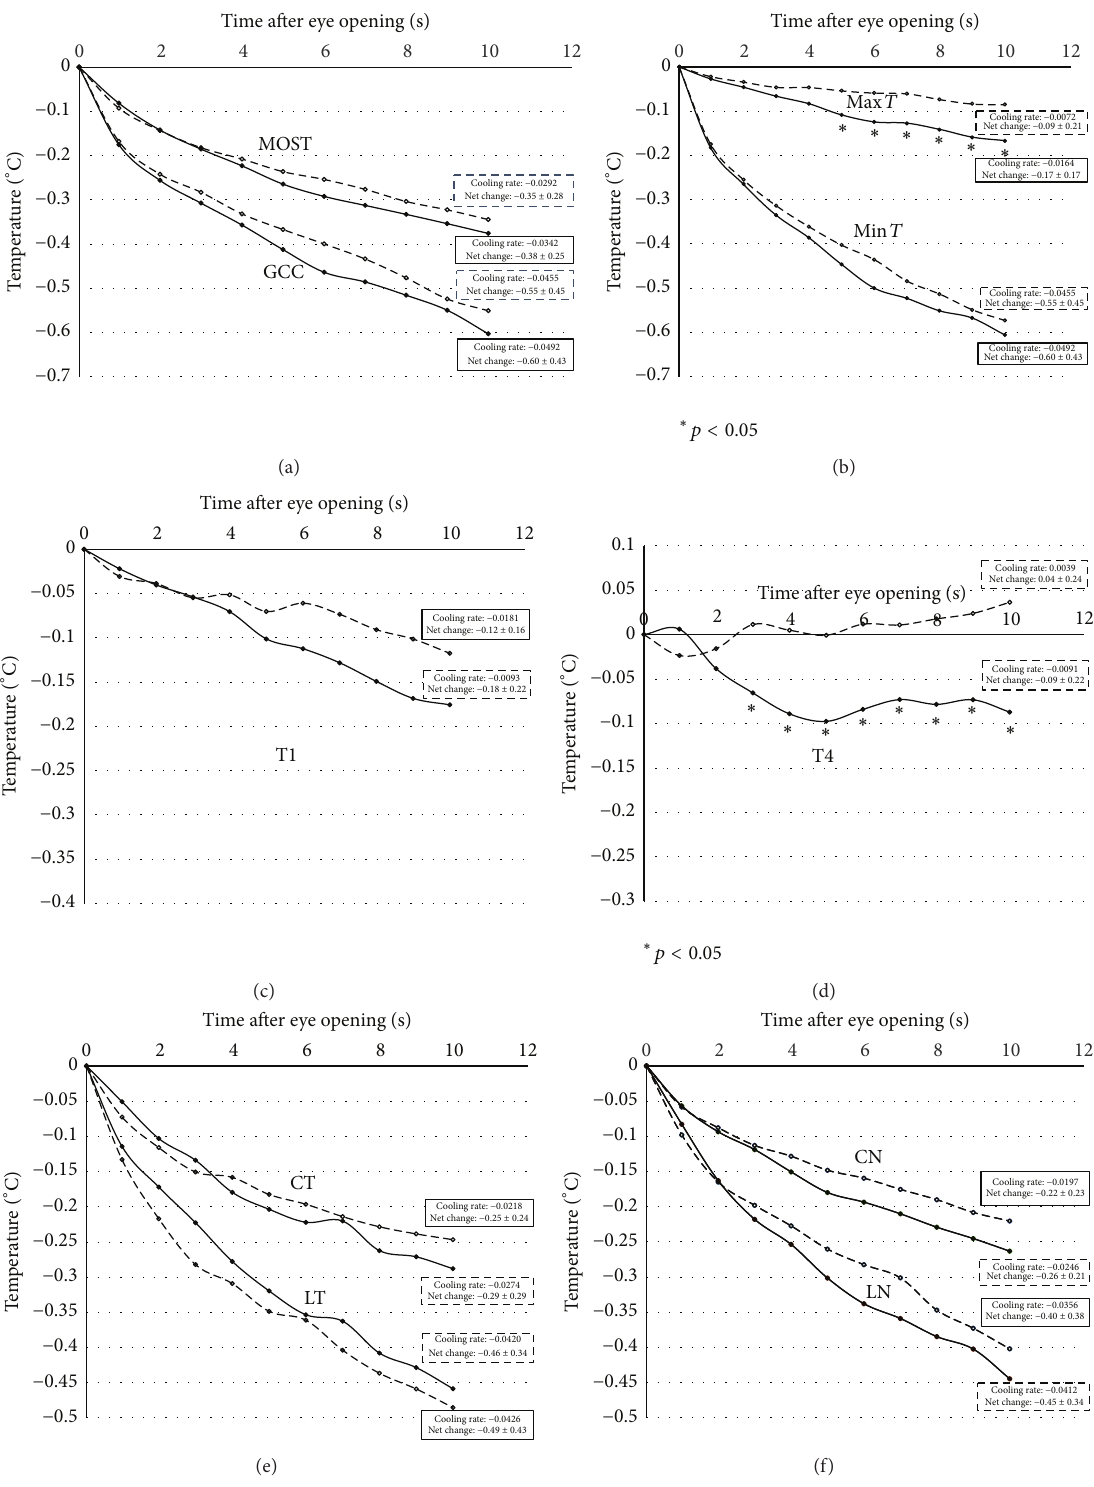
Figure 3: (Dynamic measures) graphs showing the mean change OST (relative to baseline) during the 10 s sustained eye opening: (a) GCC and MOST; (b) Min 𝑇 and Max 𝑇 ; (c) T1; (d) T4; (e) CT and LT; (f) CN and LN in (solid circles) dry eye subjects and (open circles) controls. Values in boxes represent the cooling rateand net change in OST over the 10s period in dry eye and control groups, respectively. A comparison of mean at each 1s interval was performed using unpaired 𝑡 -test, ∗ 𝑝 < 0.05 . A typical standard deviation for GCC was ± 0.29 (= average std deviation) for dry eye and ± 0.30 for controls and for MOST it was ± 0.15 for dry eye and ± 0.18 for controls. A typical standard deviation for Min 𝑇 was ± 0.33 for dry eye and ± 0.32 for controls and for Max 𝑇 it was ± 0.11 for dry eye and ± 0.13 for controls. A typical standard deviation for T1 was ± 0.14 for dry eye and ± 0.11 for controls and for T4 it was ± 0.21 for dry eye and ± 0.16 for controls. A typical standard deviation for CT was ± 0.19 for dry eye and ± 0.17 for controls and for LT it was ± 0.23 for dry eye and ± 0.29 for controls. A typical standard deviation for CN was ± 0.14 for dry eye and ± 0.16 for controls and for LN it was ± 0.22 for dry eye and ± 0.23 for